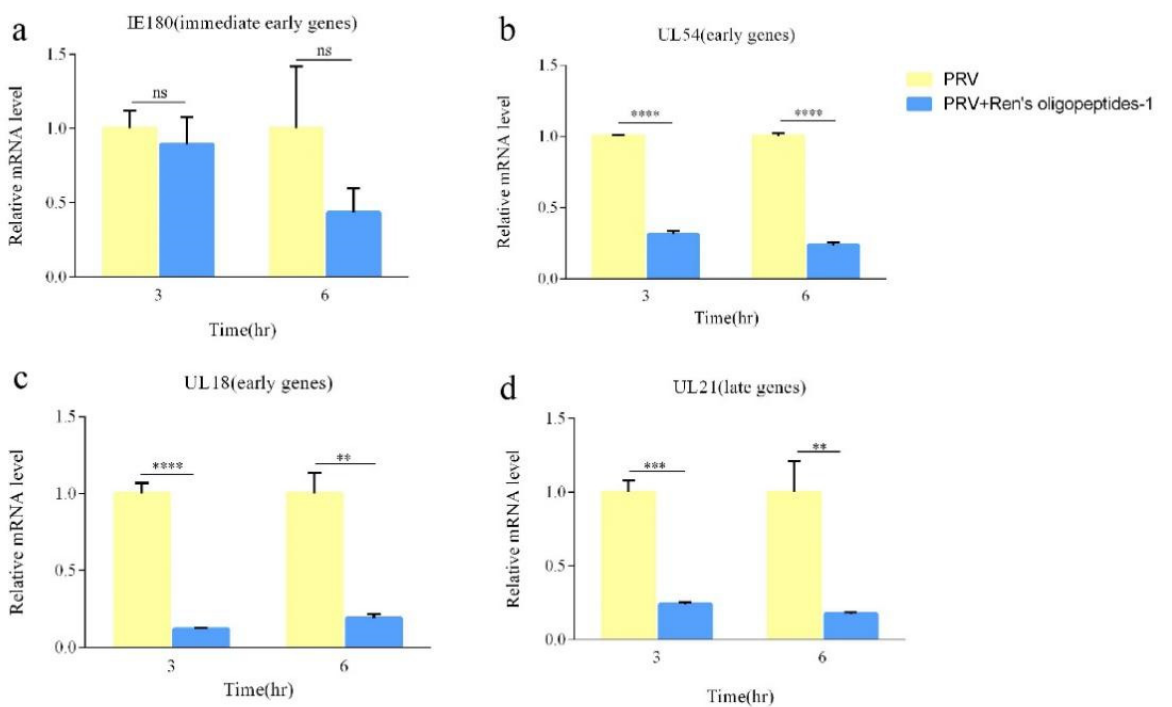
Figure 4. Viral RNA expression as measured by real-time PCR in PRV-infected PK15 cells treated with 6 mg/mL of Ren’s oligopeptides-1. ( a ) Expression levels of IE180 at 3 and 6 h following treatment with Ren’s oligopeptides-1. ( b ) Expression levels of UL54 at 3 and 6 h following treatment with Ren’s oligopeptides-1. ( c ) Expression levels of UL18 at 3 and 6 h following treatment with Ren’s oligopeptides-1. ( d ) Expression levels of UL21 at 3 and 6 h following treatment with Ren’s oligopeptides-1. ns, not significant ( p > 0.05); ** p < 0.01, *** p < 0.001, and **** p < 0.0001 from the Student’s t -test. Error bars represent SD from three independent experiments.